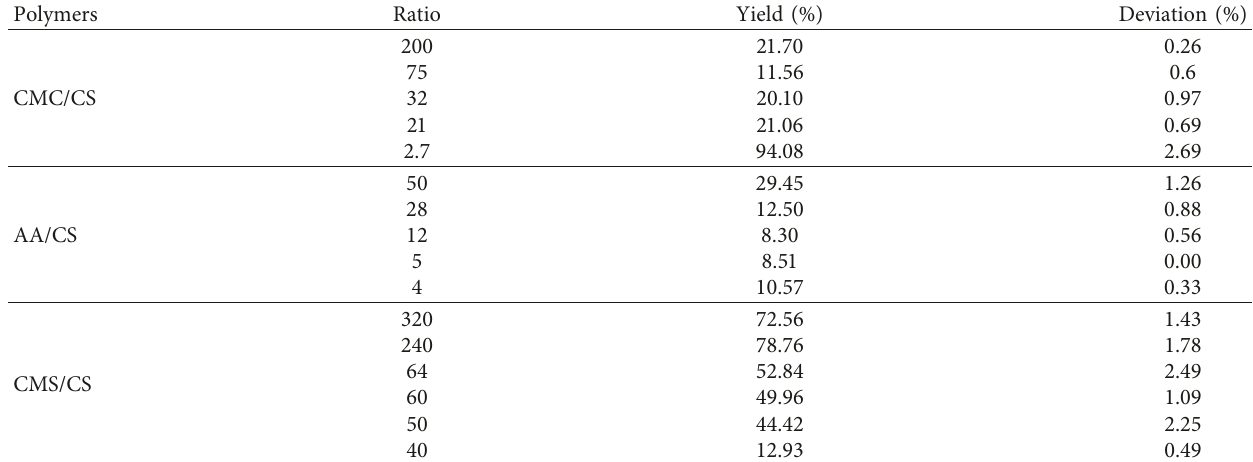
Table 2: The yield of hydrogels at varying ratios of anionic and cationic polymers.